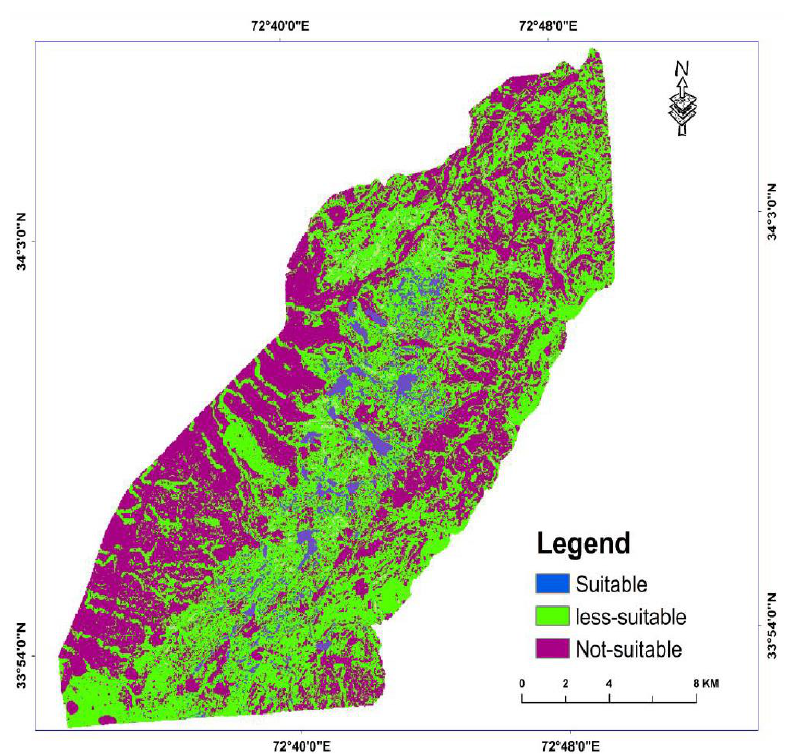
Figure 12. Categories of suitability for